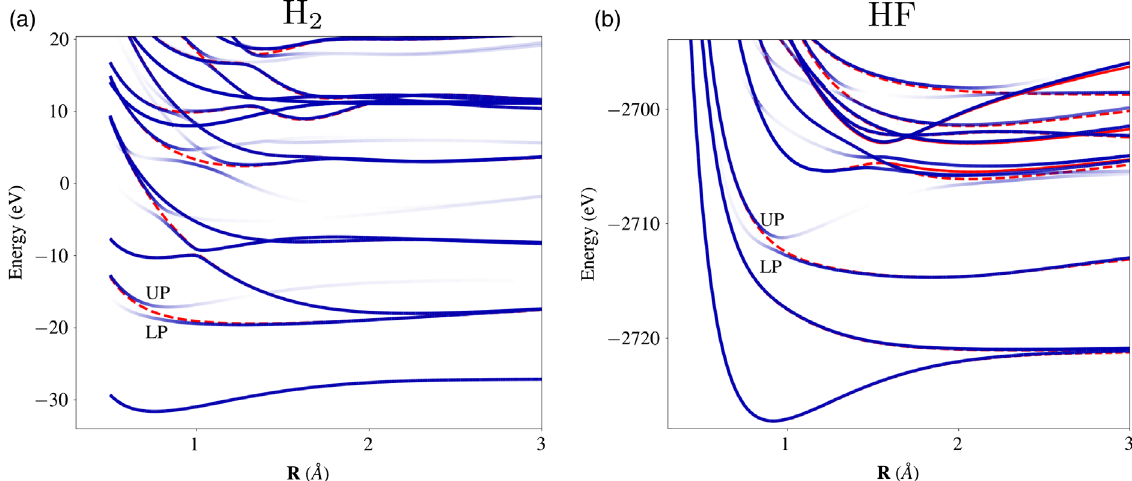
2. Potential energy curves calculated with (blue solid lines) and without (red dashed lines) an optical cavity for (a) H 2 and (b) HF. The polarization is along the main axis of the molecules, and the field is in resonance with the first bright excitation of the system at its equilibrium geometry. The coupling strength is set to λ ¼ 0 . 05 in both cases. The blue color map indicates the electronic or photonic character of the